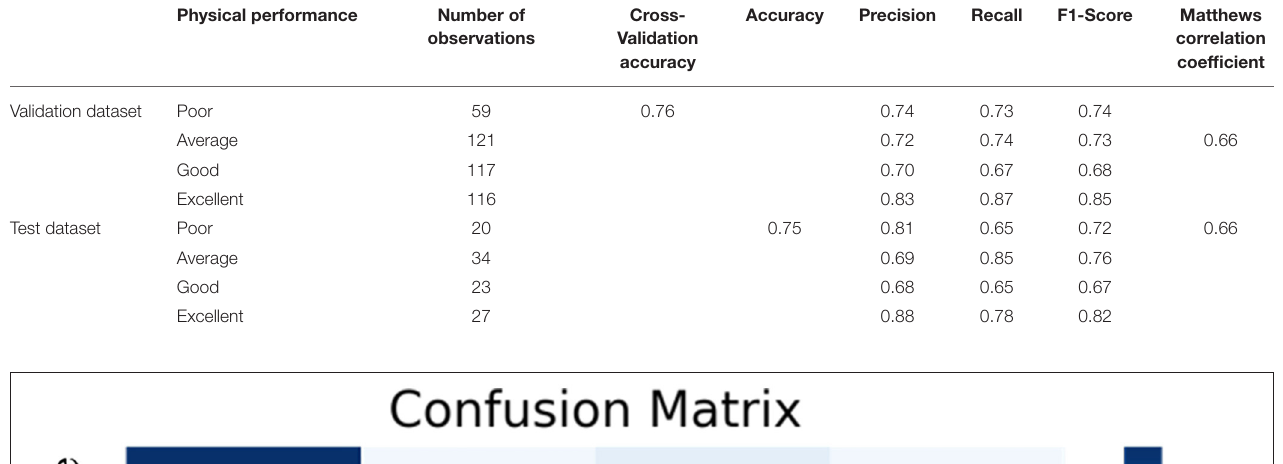
TABLE 2 | The classification report of linear SVC classifier.